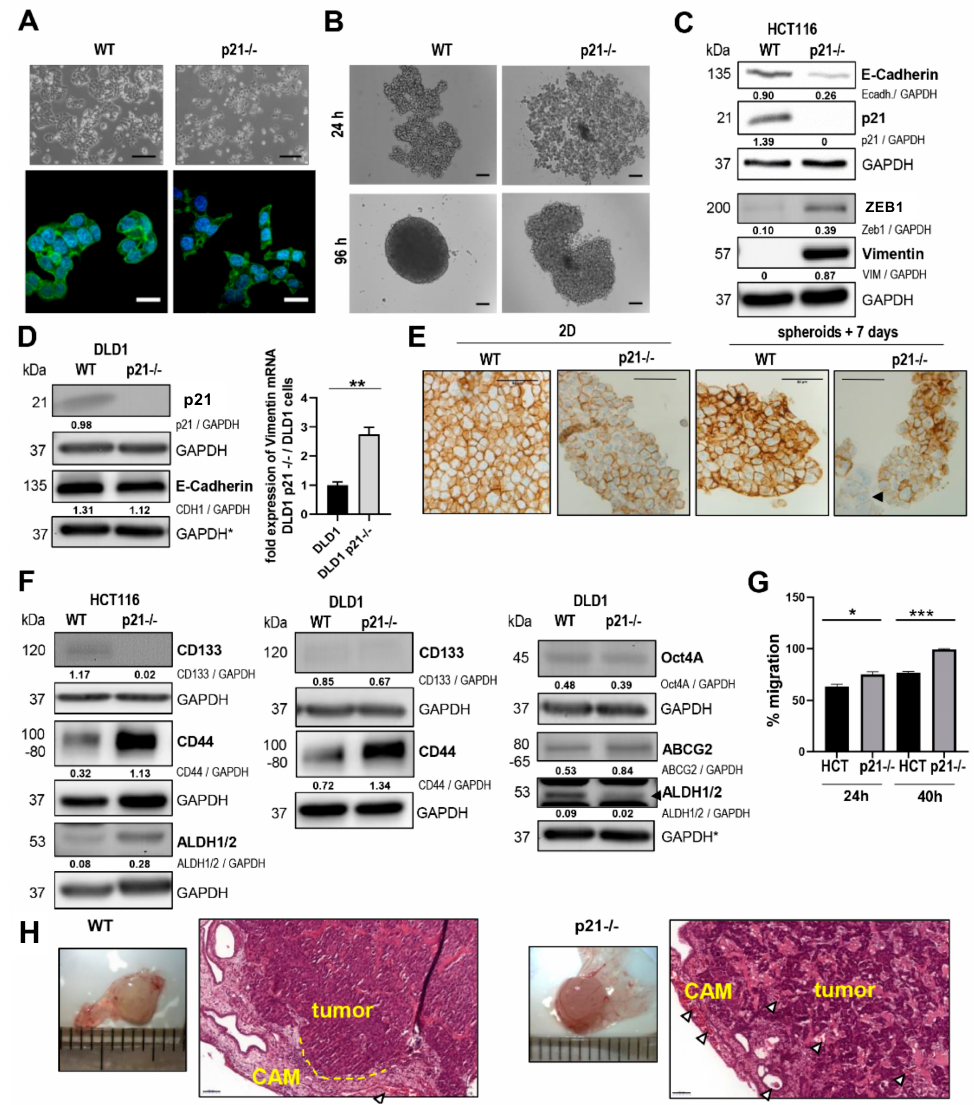
Figure 1. Comparison of colon cancer HCT116 WT versus HCT116 p21-/- cells. ( A ) Phase contrast and immunofluorescence confocal microscopy images of HCT116 WT and p21-/- cells. Top panels: phase contrast magnification = 100×; panels below: confocal magnification = 630×, blue: DAPI, green: F-Actin (scale bar of Phase contrast = 200 µm, confocal scale bar = 20 µm; n ≥ 4). ( B ) Spheroid formation ability of HCT116 WT and p21-/- cells in a hanging drop assay after 24 and 96 h (scale bar = 500 µm). ( C ) Western blots of HCT116 WT, HCT116 p21-/-, ( D ) DLD1 WT, and DLD1 p21-/- cells grown in 2D cultures, used to analyze the expression of EMT markers (Vimentin, ZEB1) and p21 and the epithelial marker E-cadherin (CDH1); n ≥ 2. Fold expressions are presented relative to GAPDH loading control. * Markers were blotted on the same gel. Fold changes of VIM expression in DLD1 p21-/- cells when compared to WT cells as determined by qPCR (** p -value < 0.01, n = 3; biological triplicate and technical triplicate). ( E ) Immunohistochemical staining for E-cadherin in fixed cells grown in 2D cultures and 3D cultures with hanging drops (scale bar = 50 µm). ( F ) Western blots of HCT116 WT, HCT116 p21-/-, DLD1 WT, and DLD1 p21-/- cells to investigate the stemness markers CD133, CD44, ALDH1/2, OCT4A, and ABCG2 ( n ≥ 2). Fold expressions presented relative to GAPDH loading control. * Markers were blotted on the same gel ( G ) Evaluation of the wound healing assay after 24 and 40 h for cells treated with 10 nM of mitomycin C (average of 7 wells with 3 single measurements per well) (Image-Pro Plus). (* p -value < 0.05, *** p -value < 0.001). ( H ) Representative light microscopy images of fixed and extracted chorioallantoic membrane (CAM) tumors derived from HCT116 WT and p21-/- cells (magnification = 100×; scaling segments = 1 mm; n ≥ 8) and representative images of formalin-fixed and paraffin-embedded (FFPE) CAM sections stained